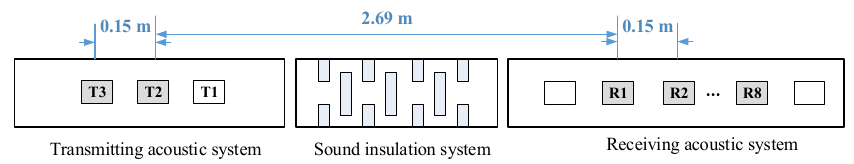
Figure 4. Established structural diagram of the designed sources.